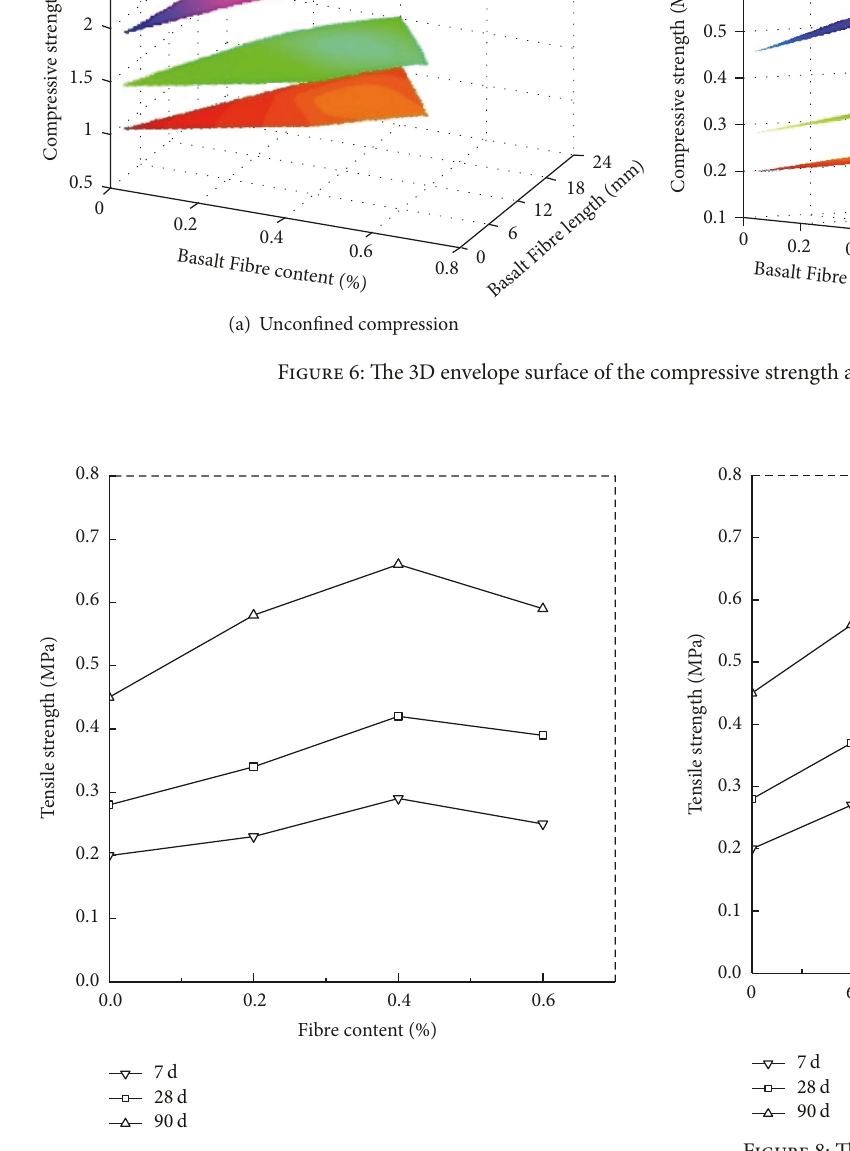
Figure 7: The relations of fibre content and strength. Figure 8: The relations of fibre length and